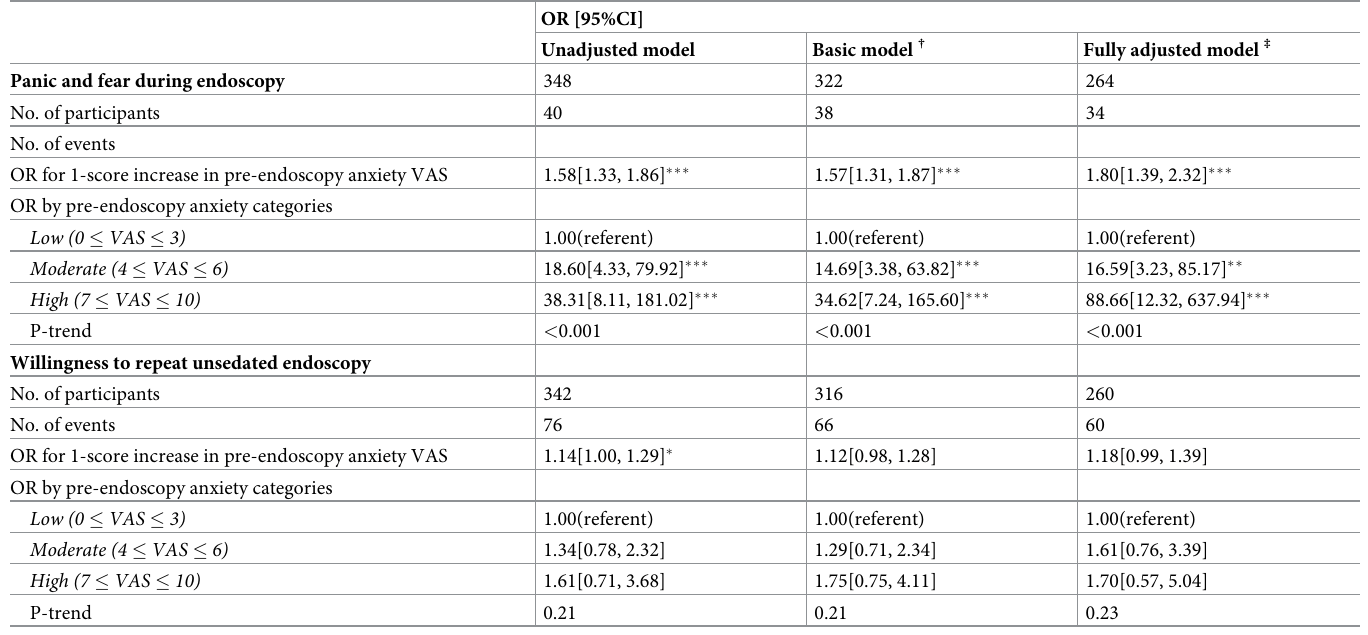
Table 3. Associations of pre-endoscopy anxiety with panic/fear during endoscopy and the willingness to repeat unsedated